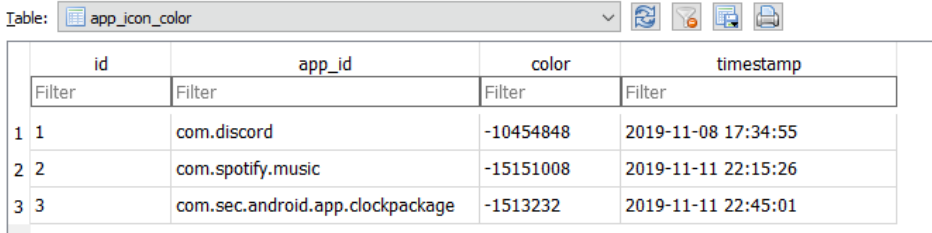
Figure 5. App ID data found in device_notification.db file using DB Browser for SQLite.